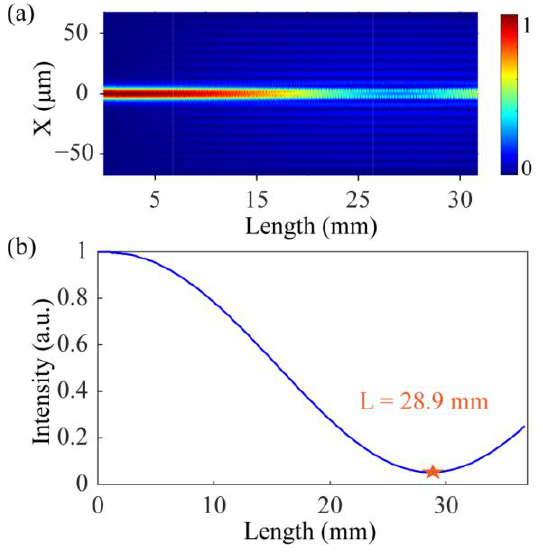
Figure 3. ( a ) Simulated transmission optical field distribution of the SMF-HLPG. ( b ) The light intensity of fundamental mode along the SMF-HLPG.